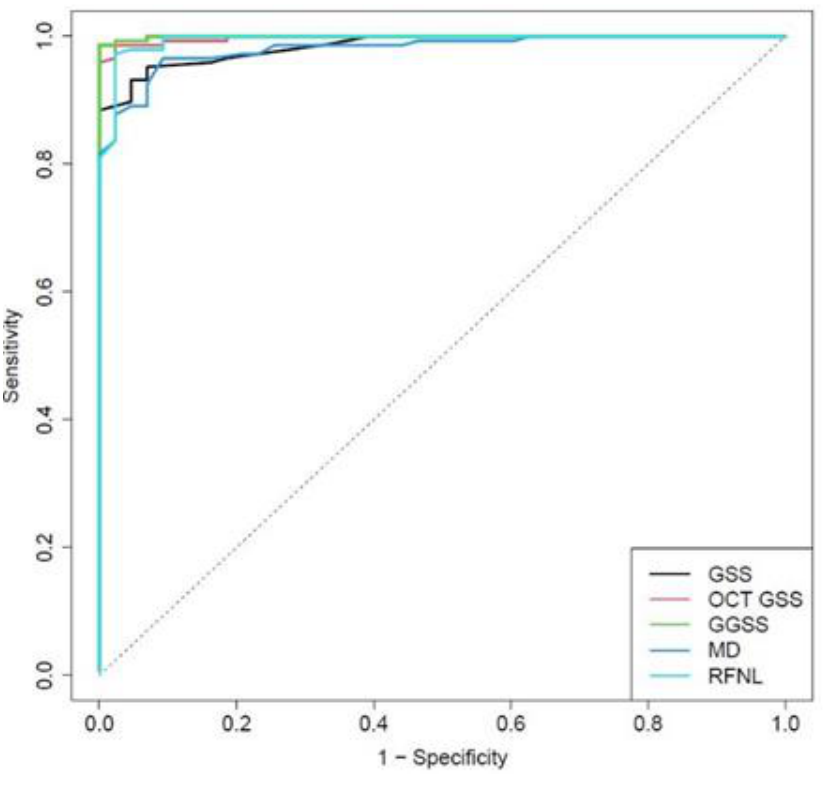
Figure 3. ROC curves for GGSS and the other methods used to classify all of the 147 glaucoma cases. From a clinical point of view, it should be highlighted that the GGSS ability to dif- ferentiate patients with early glaucoma (53 cases) from normal subjects was superior to MD, average RNFL thickness, GSS 2, and OCT GSS when considered in isolation. The area under ROC values were 0.998, 0.957, 0.993, 0.948, and 0.989 for GGSS, GSS 2, OCT GSS, MD, and RNFL, respectively (statistical significant differences for GGSS and MD; p = 0.013, p = 0.017) (Figure